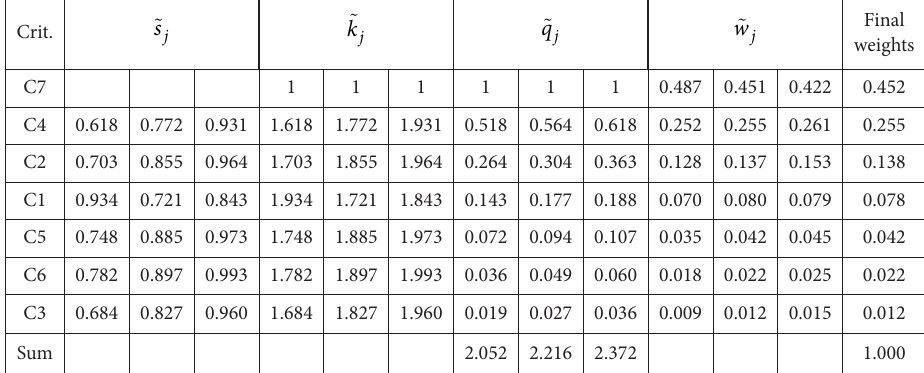
Table 4. Final values of fuzzy SWARA weights obtained by number defragmentation